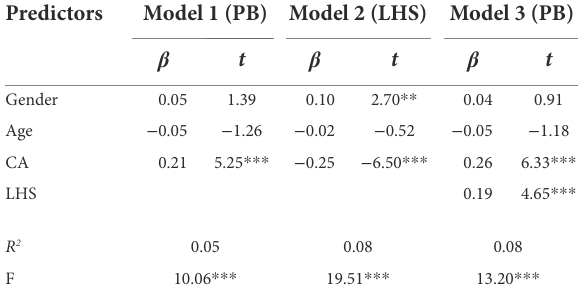
TABLE 1 Descriptive analysis and correlations among main study variables ( n = 637).